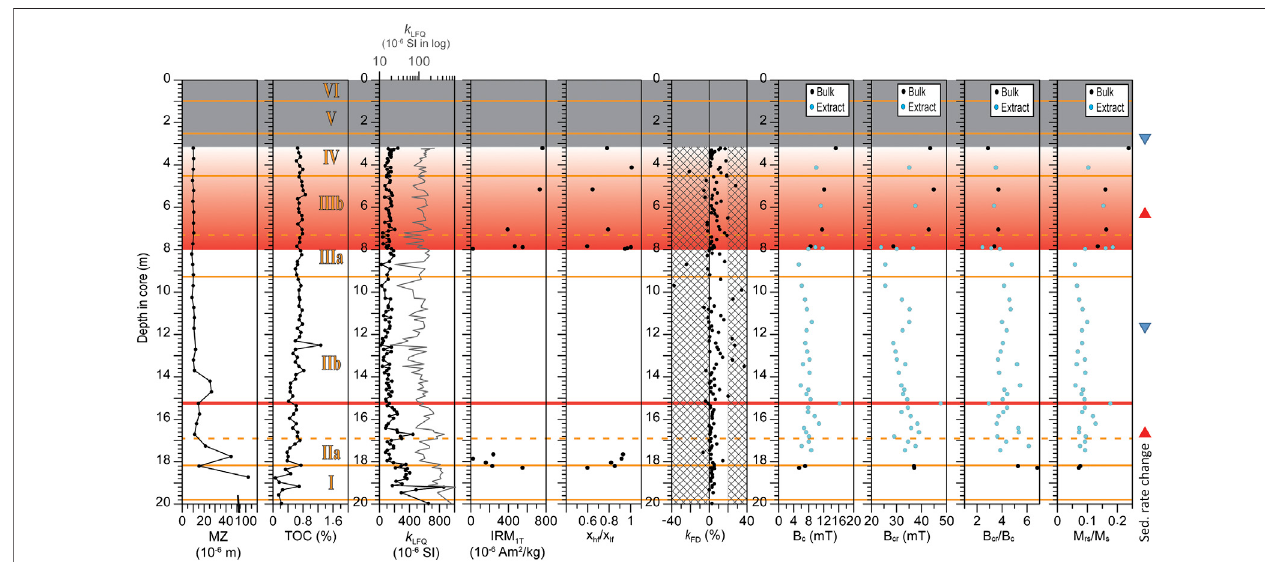
FIGURE 4 | Downcore variations in mean grain size (MZ), total organic carbon (TOC) content and various magnetic properties for bulk sediment samples of the YAR-4 core. The magnetic properties shown include bulk magnetic susceptibility ( k LFQ , in both linear and log scale), isothermal remanent magnetization (IRM) intensity imparted at 1 T (IRM 1T ), high- fi eld to low- fi eld magnetic susceptibility ratio ( χ hf / χ lf ), frequency-dependent magnetic susceptibility ( k FD ), coercive force (B c ), coercivity of remanence(B cr ),ratioofB cr toB c (B cr /B c ),andratioofsaturationremanencetosaturationmagnetization(M rs /M s ).InB c ,B cr ,B cr /B c ,andM rs /M s plots,exceptionally, therespectivevaluesformagneticextractswerealsoshown(assumingtheirvaluesfortheextractshavingnosigni fi cantdifferenceswiththoseforbulksediments).Inthe k FD – depth diagram, the hatched area denotes lack of meaningful k FD values due to weak signals. Sedimentary unit divisions (I to VI) are shown by orange lines. On the rightedgeofthe fi gure,thedepthsatwhichsigni fi cantchangeinsedimentationrateappearedbasedontheage-depthmodel( Figure3 )areshown:redtriangledenotes increase in sedimentation rate at above the depth, and blue inverse triangle denotes its decrease at above the depth. Gray-shaded area denotes lack of analyzed data.